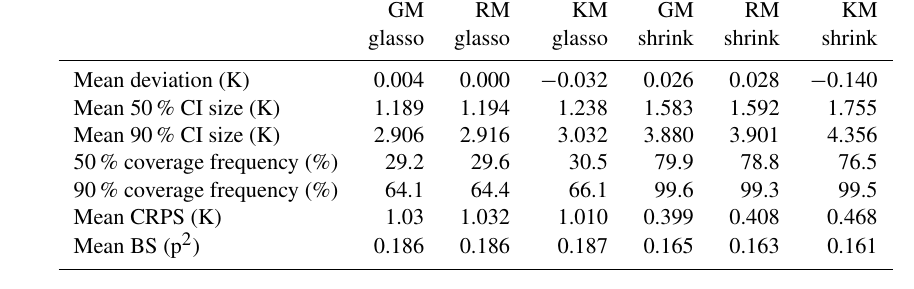
Table 2. Summary measures for ITEs and CVEs. Summary measures for ITEs and CVEs with the six process stage models.